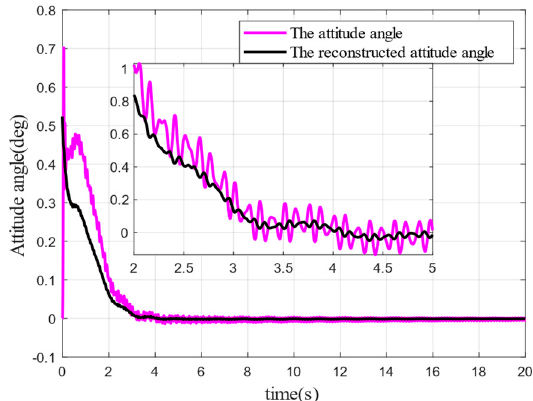
Figure 3. Attitude angle reconstruction without external interference.